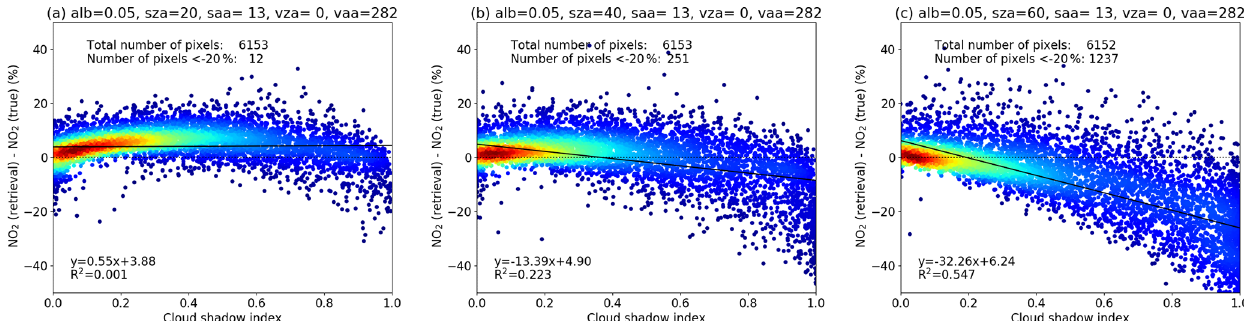
Figure 3. The difference between the retrieved and “true” NO 2 TVCDs versus the cloud shadow index for three low-earth-orbiting geom- etry cases. Results are shown for cloud-filtered pixels and solar zenith angles of (a) 20, (b) 40, and (c) 60 ◦ , albedo = 0.05, solar azimuth angle = 13 ◦ , satellite azimuth angle = 0 ◦ , and satellite viewing angle = 282 ◦ . The black lines are linear fits, and the fit parameters and R 2 are given in the individual plots. The data in (c) are for the case presented in Fig. 1.